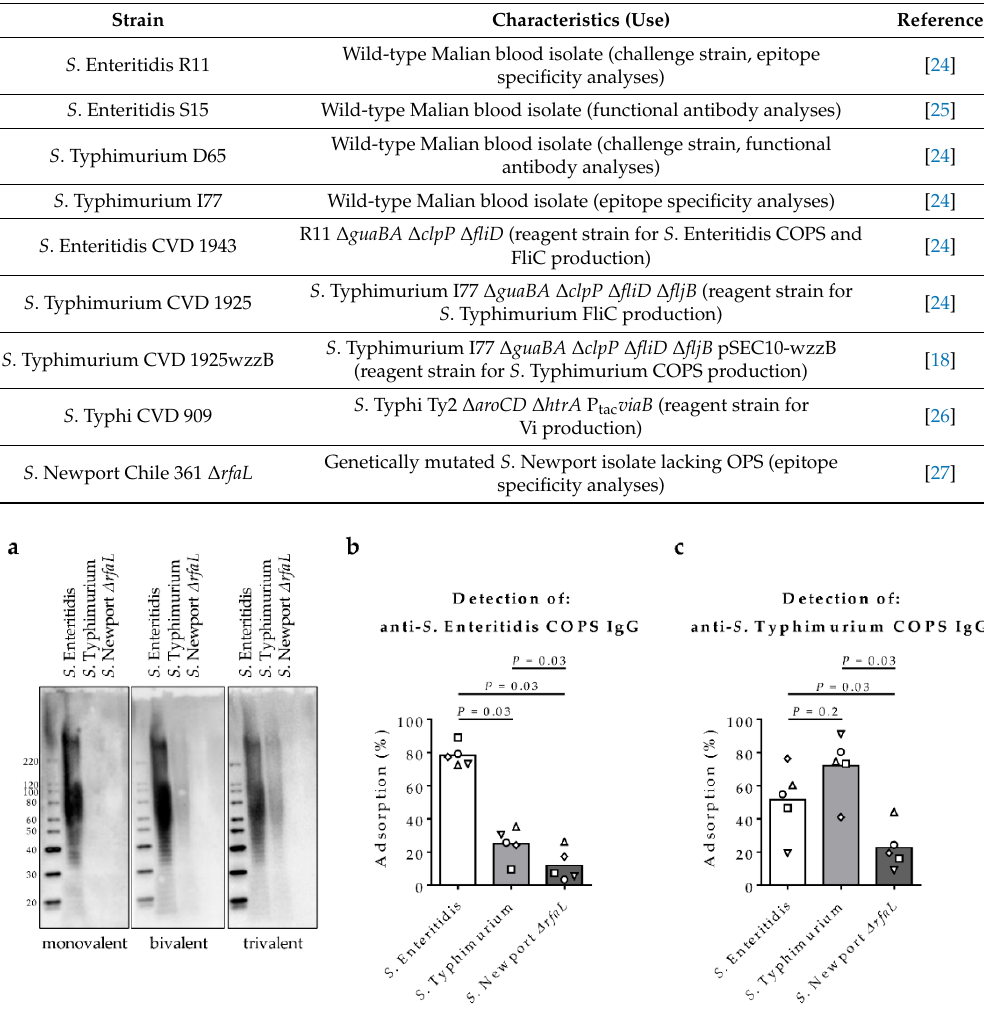
Figure 3. Epitope mapping of serum IgG from rabbits immunized with Salmonella glycoconjugates. Sera were assessed for binding by ( a ) Western blot of crude lipopolysaccharide (LPS) extracts from S .